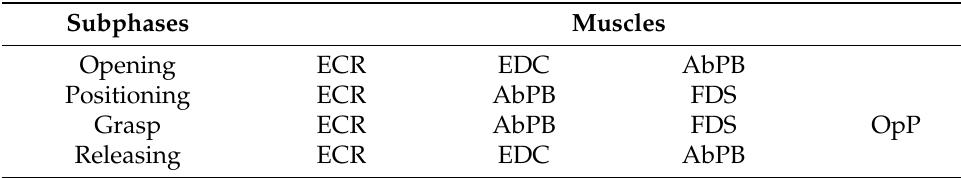
Table 2. Stimulation sequence for lateral grasping.